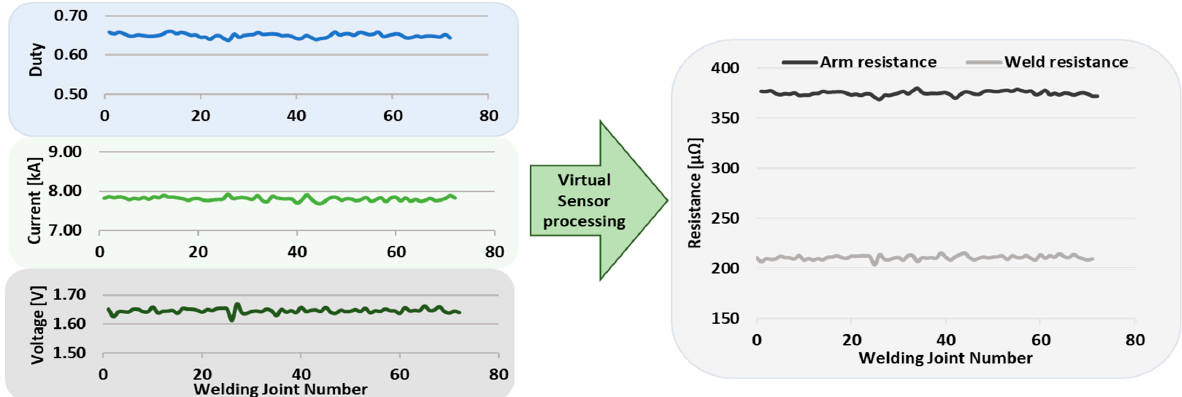
Figure 5. Virtual sensor operation. Input and output signals.